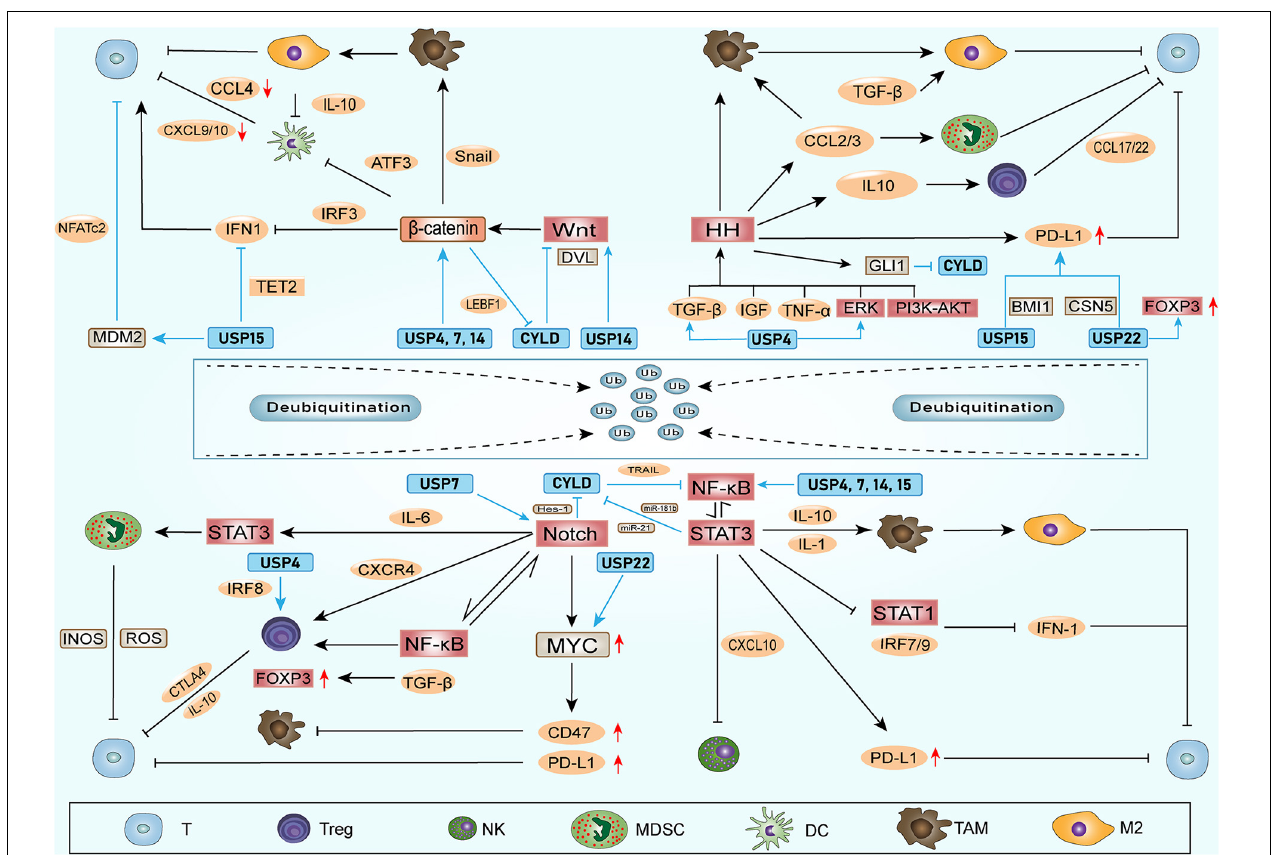
FIGURE 2 | DUBs involved in stem cell factors, SRSs and ITAIM. DUBs can regulate the stem cell factors and the components of SRSs, promoting stemness of CSCs. Additionally, DUBs can affect ITAIMs directly by acting on cytokines, inhibitory immune checkpoints or other oncogenes. The combination of DUBs with substrates leads to deubiquitination and protects substrates from degradation. Therefore, the protein level of the substrate and the signaling pathways involved are upregulated. The arrow at the end of the line in the figure represents upregulation, and the horizontal line represents